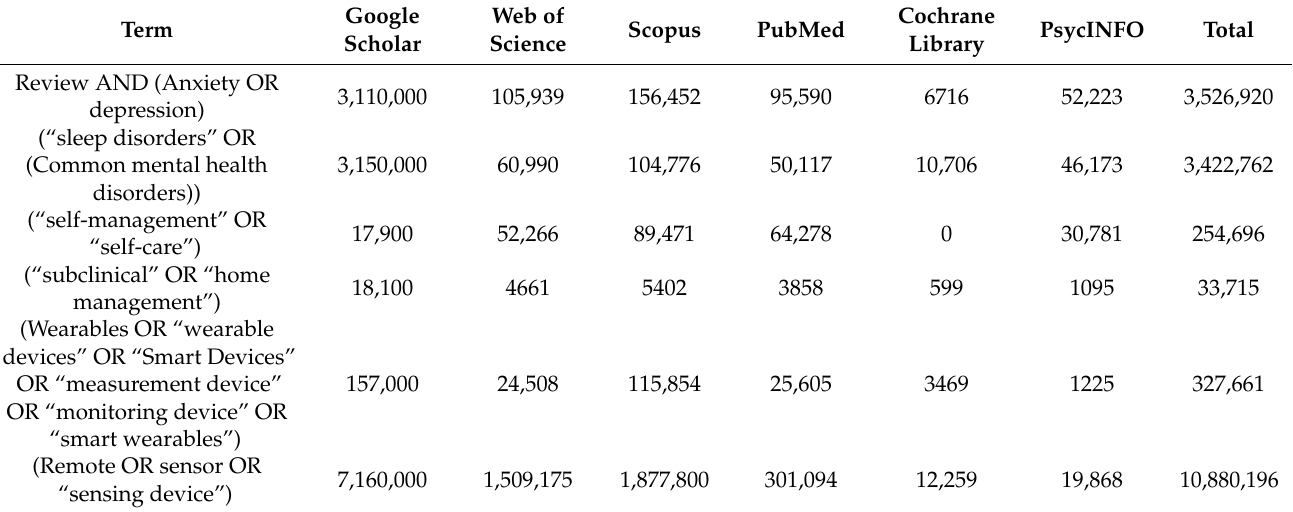
Table 1. Details the initial search terms, the quantity of returned results and the originating